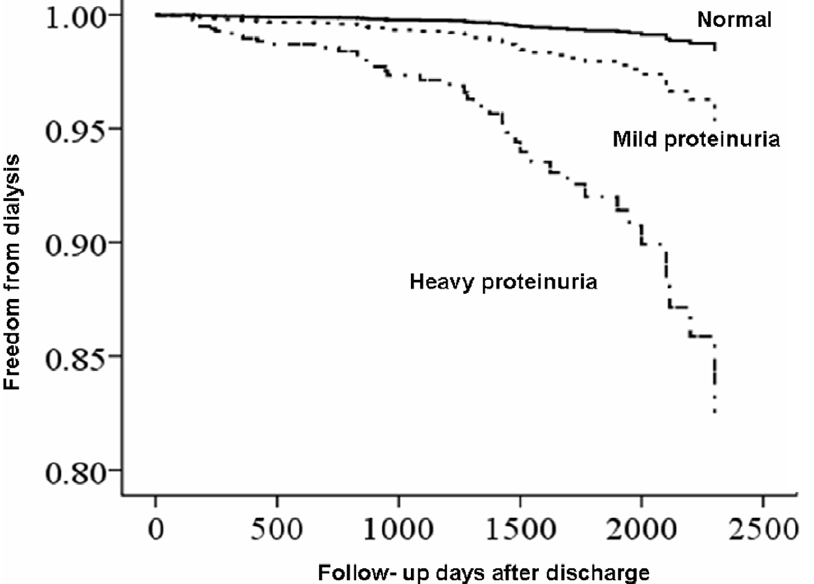
Figure 1. Proportion of freedom from long- term dialysis dependence, stratified by different severities of proteinuria defined by preoperative dipstick. (Mild proteinuria, p=0.166; Heavy proteinuria, p=0.001; No proteinuria was the reference calculated by multivariable Cox proportional hazard analyses).